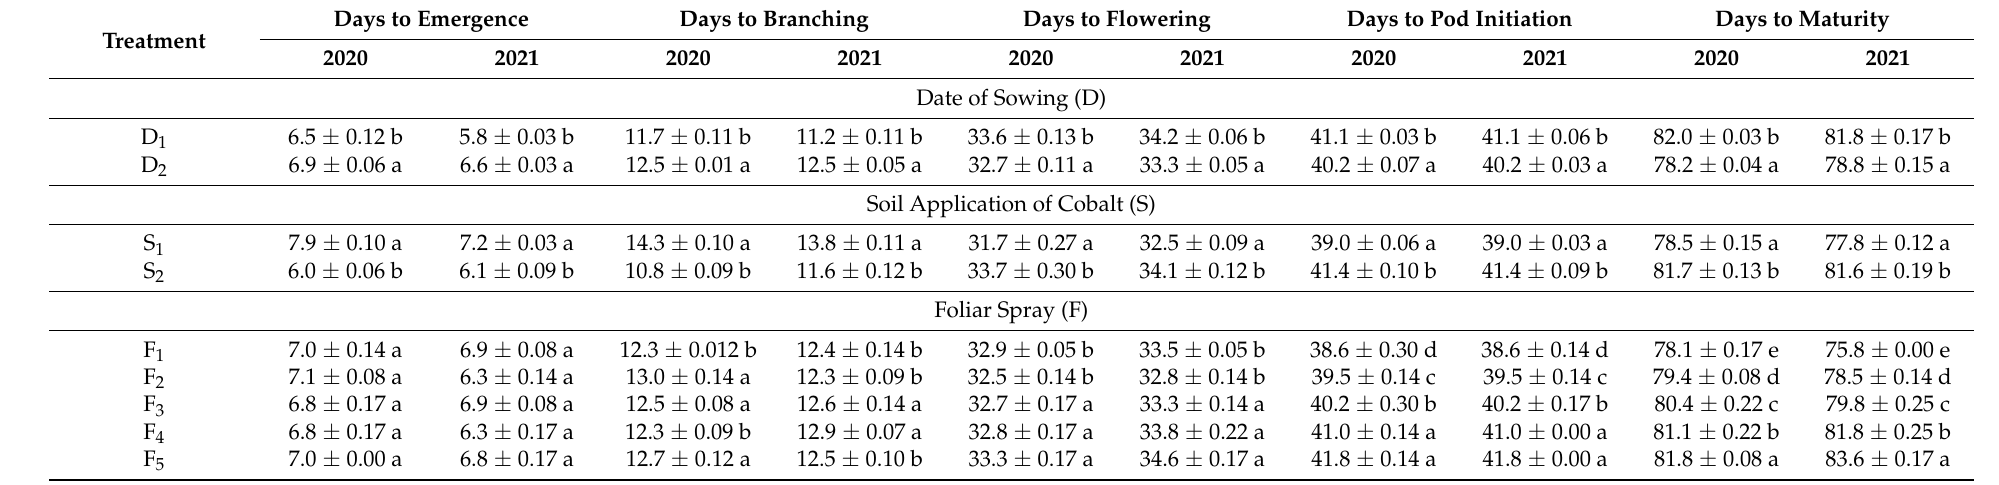
Table 3. Phenophase duration of black gram as influenced by sowing dates and nutrients